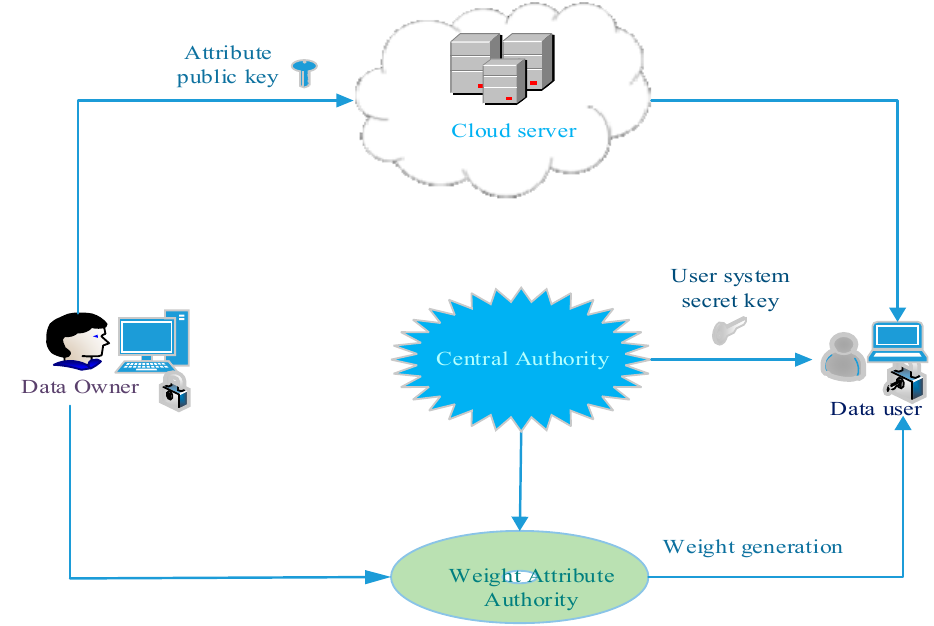
Figure 1. Proposed blowfish hybridized weighted attribute-based Encryption (BH-WABE) scheme.